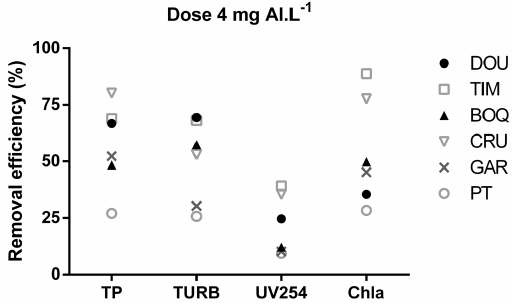
Figure 2. Removal efficiency (%) for total phosphorus (TP), turbidity (TURB), humic substances (UV and chlorophyll-a (Chl-a) in raw water from Dourados (DOU), Timbaúba (TIM), Boqueirão (BOQ), Cruzeta (CRU), Gargalheiras (GAR) and Passagem das Traíras (PT) reservoirs, after coagulation-flocculation with the dose of 4 mg Al L -1 and 30 minutes of